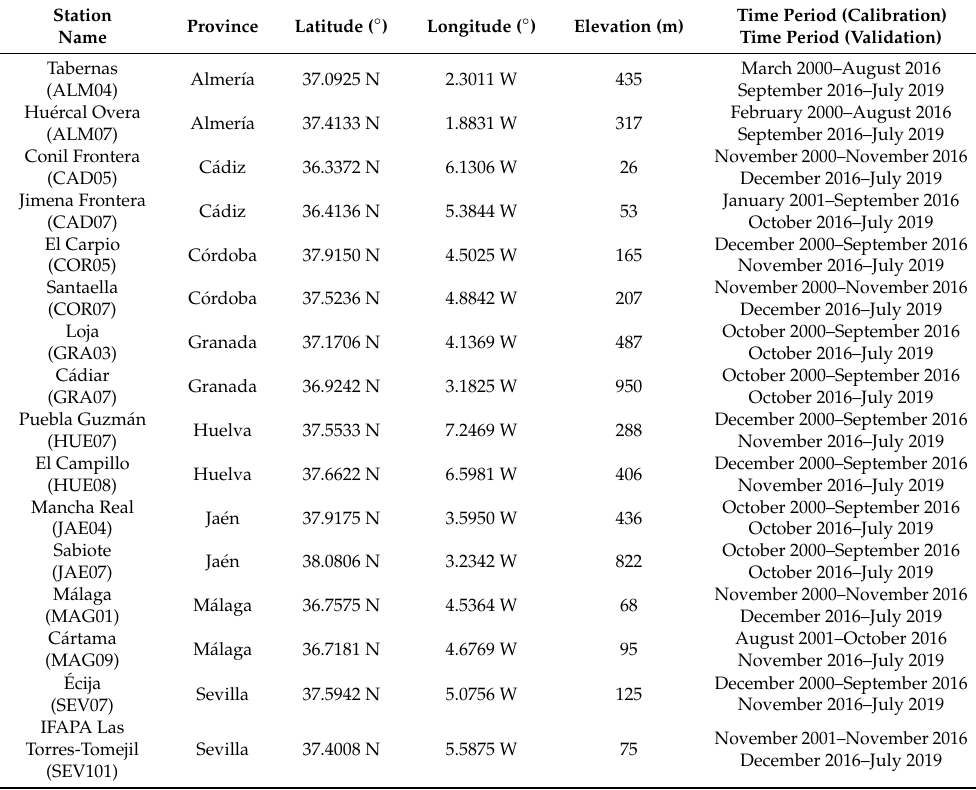
Table 1. Name of the station, province, coordinates, elevation and data time-period of the weather stations used in this study (Southern